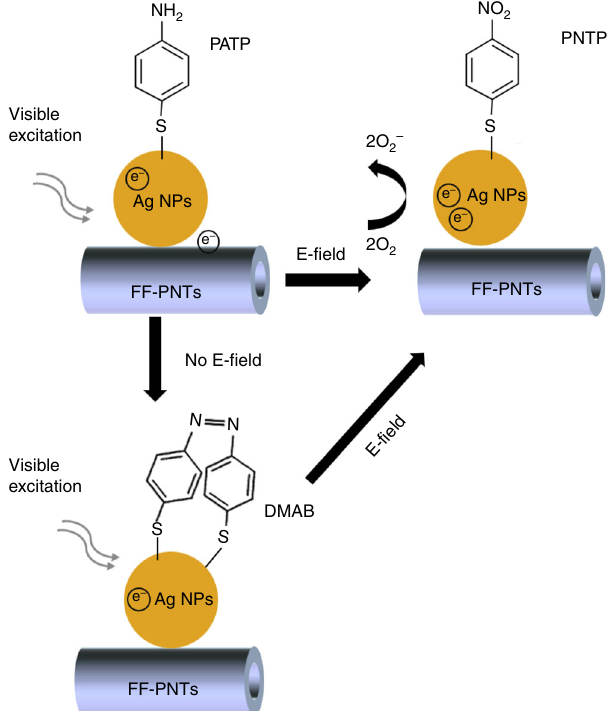
Fig. 3 Mechanism for oxidation of PATP to PNTP on the FF-PNT/Ag NP template. When the FF-PNT/Ag NP template was excited by the Raman laser in the presence of an electric fi eld, LSPR-excited hot electrons and additionally electrons relocated from FF-PNTs to Ag NPs contribute to the O 2 activation step, resulting in the creation of PNTP rather than DMAB. Also shown also is the formation of DMAB on the FF-PNT/Ag NP template, which occurs at zero fi eld. The DMAB dimer may subsequently convert to PNTP upon application of an electric fi eld, together with optical excitation of the Ag NPs